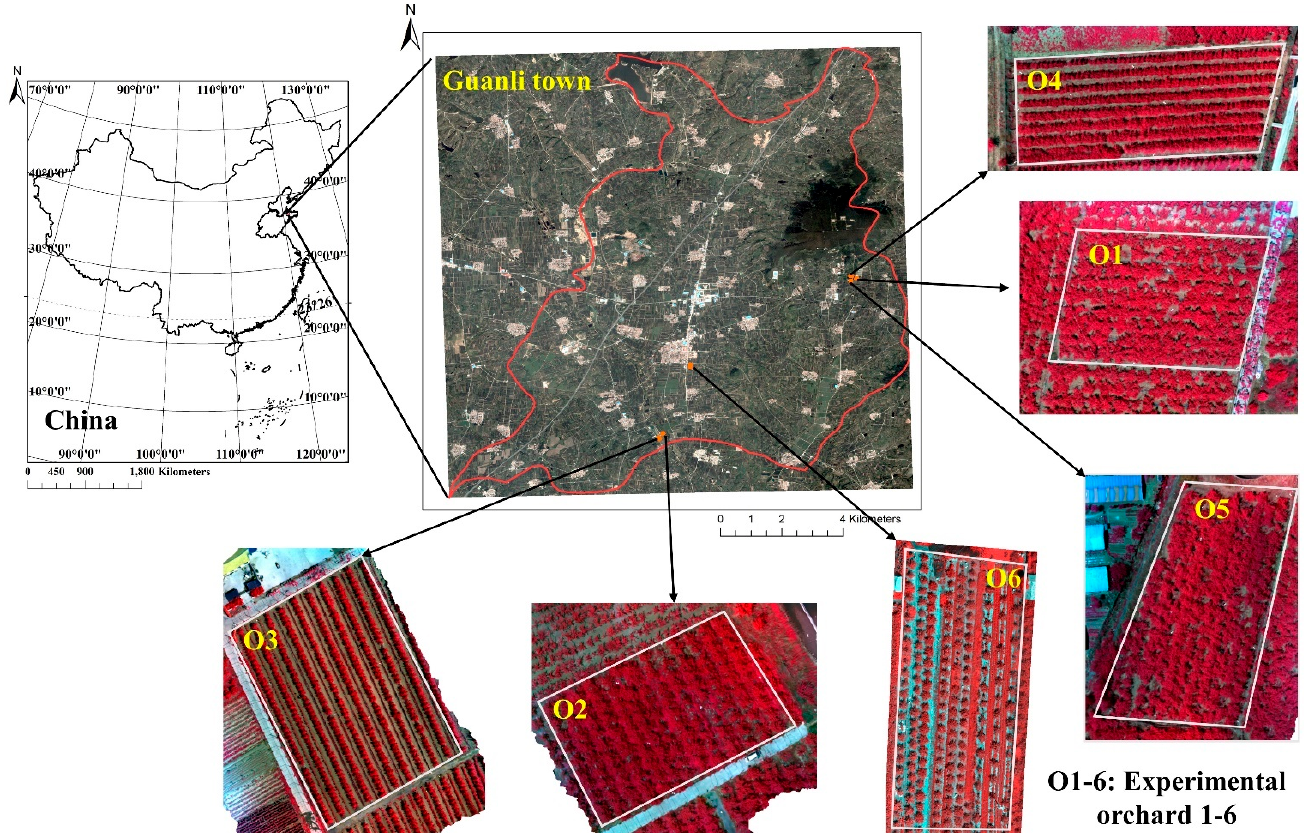
Figure 1. Study region and experimental orchards. The images of experimental orchard 1–6 were captured by an unmanned aerial vehicle in late May and displayed in false color.